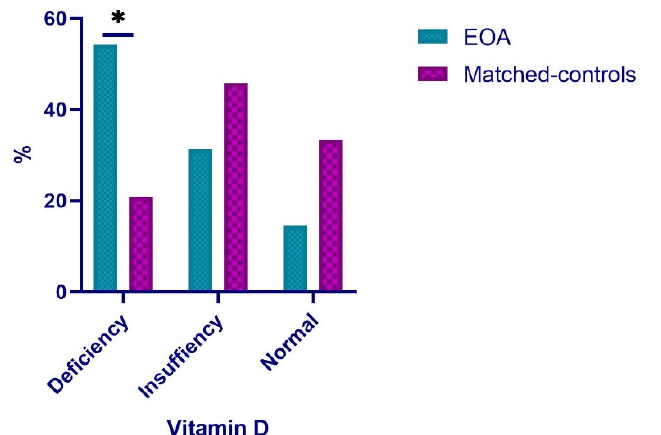
Figure 1. Distribution of EOA patients and matched controls according to vitamin D levels. * p < 0.05; EOA: Early Osteoarthritis.